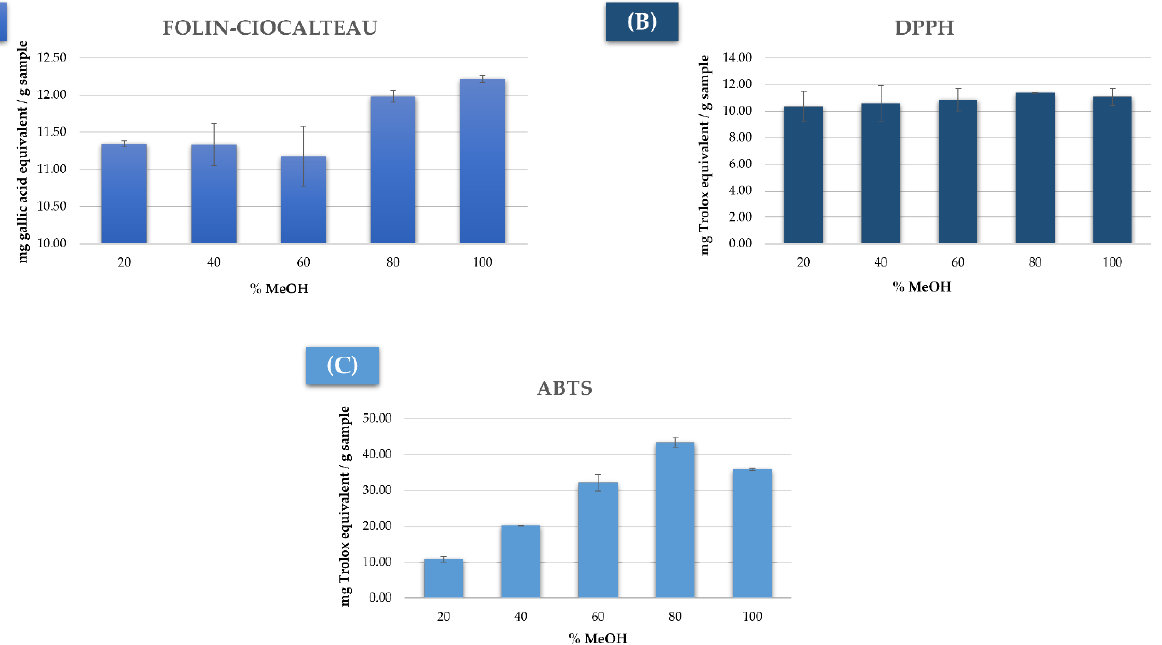
Figure 1. Results from the analysis of mushroom extracted by UAE using different % MeOH:H 2 O by ( A ) Folin–Ciocalteu method (milligrams of gallic acid equivalent/gram of sample), ( B ) DPPH method (milligrams of Trolox equivalent/gram of sample), and ( C ) ABTS method (milligrams of Trolox equivalent/gram of